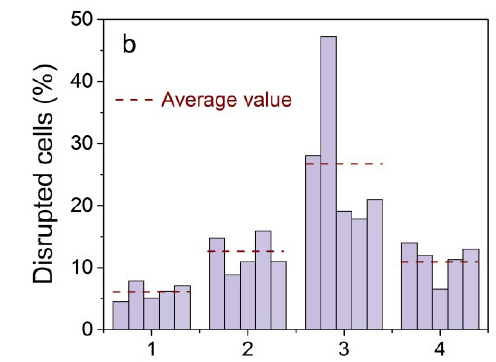
Figure 15. A typical picture in a microscope chamber; yellow objects with a blue border are living cells, blue spots are destroyed cells ( a ). Data of statistical processing of living and destroyed cells on five independent probes of each sample ( b ). (1) control cells (natural mortality), (2) a mixture of cells and Fe 3 O 4 @C NPs functionalized with aptamers without magnetic field exposure; (3) a mixture of cells and Fe 3 O 4 @C NPs with functionalized aptamers after action of a low-frequency magnetic field; and (4) a mixture of cells with initial NPs after action of a low-frequency magnetic field.